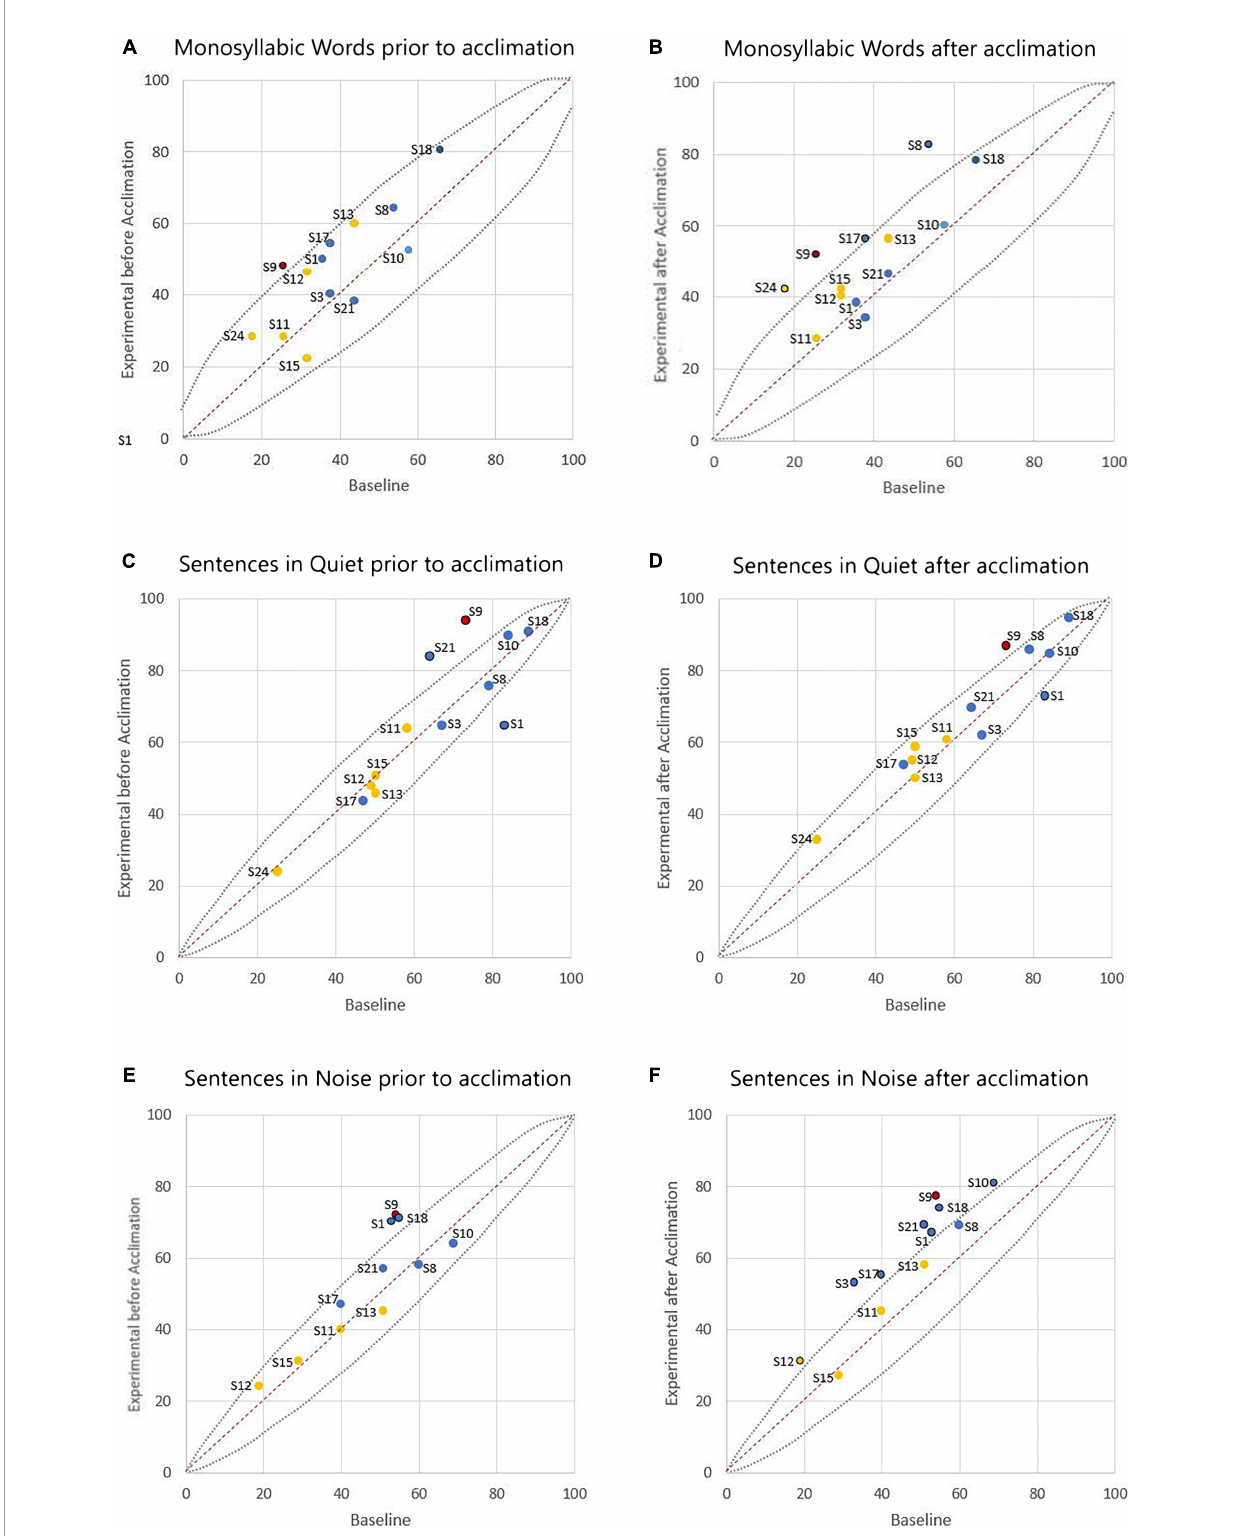
FIGURE2 Comparison of individual speech perception scores (in percent correct) with the participant’s baseline program versus the experimental program. The left column (A,C,E) represents outcomes prior to the acclimation period, and the right column (B,D,F) represents outcomes following the acclimation period. The dashed lines show 95% confidence intervals for each test. Scores above the dashed line indicate statistically better performance with the experimental program. Scores below the dashed line indicate statistically poorer performance with the experimental program. Scores within the dashed lines indicate statistical equivalence. Data is colored to note cochlear implants (CI) device used (blue indicating AB, yellow indicating CN, and red indicating ME). Data point labels represent the participant